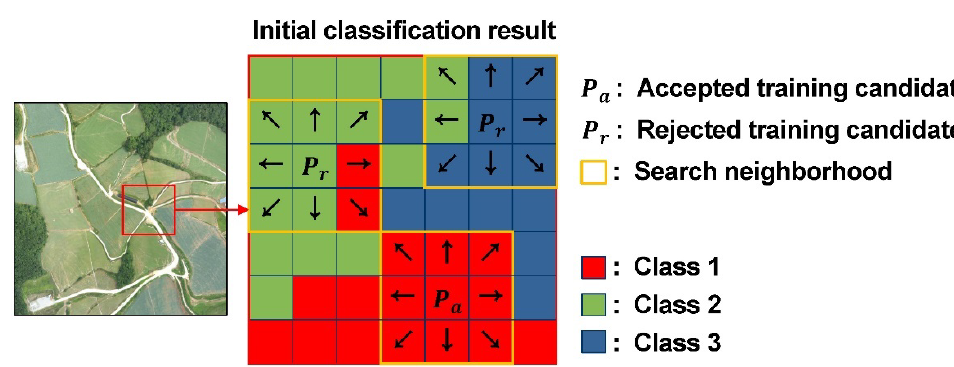
Figure 4. An illustration of the second constraint on updating the initial training candidates using the local spatial contextual information. The arrow indicates the neighboring pixels within a search neighborhood.